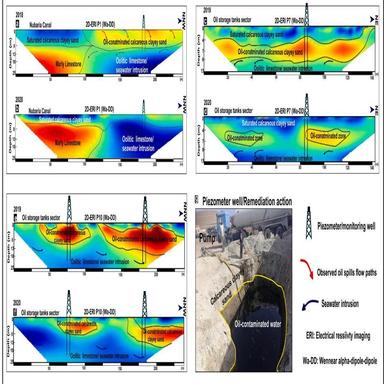
Advanced time-lapse 2D-ERI inversion results over two years showing the subsurface resistivity variations after digging trenches and withdrawing the oilcontaminated water.